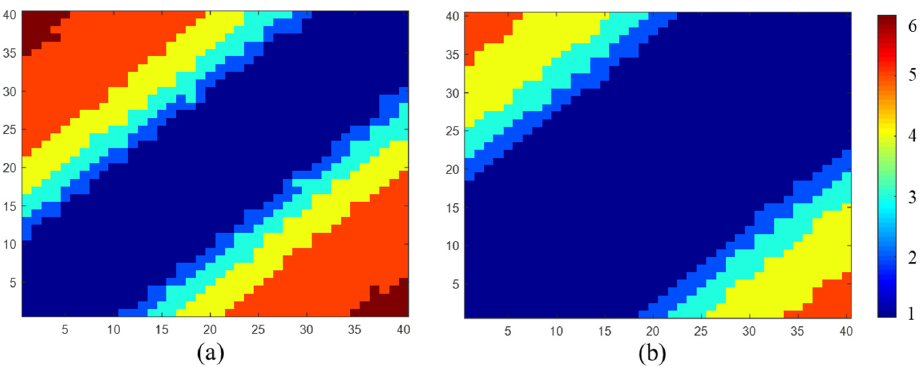
Figure 5. The value of s with a window of ( a ) 5 5 × pixels and ( b ) 7 7 × pixels.